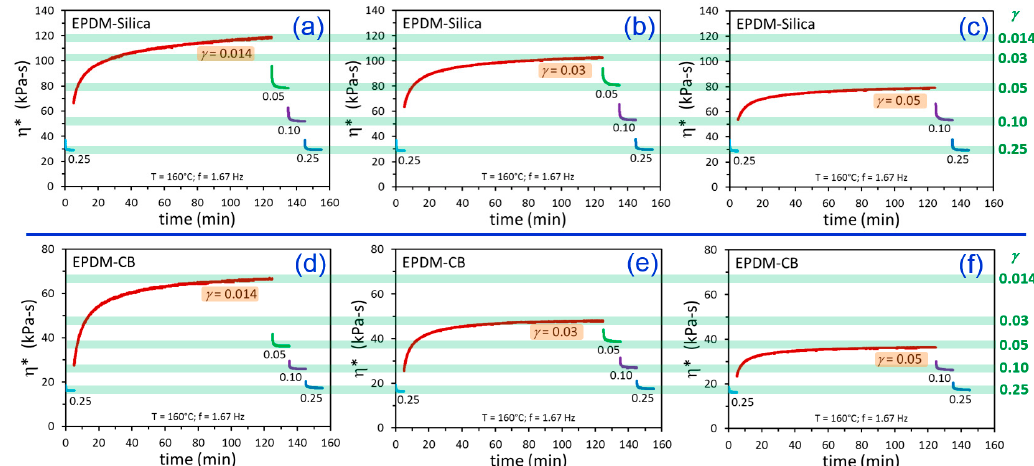
Figure 4. Time-dependent dynamic viscosity results for EPDM-Silica ( a – c ) and EPDM-CB ( d – f ) from testing using the indicated strain amplitude histories. The green bars represent the apparent equilibrium η * values at the various values of γ . Note the different y-axis scalings for EPDM-Silica ( a – c ) and EPDM-CB ( d – f ).